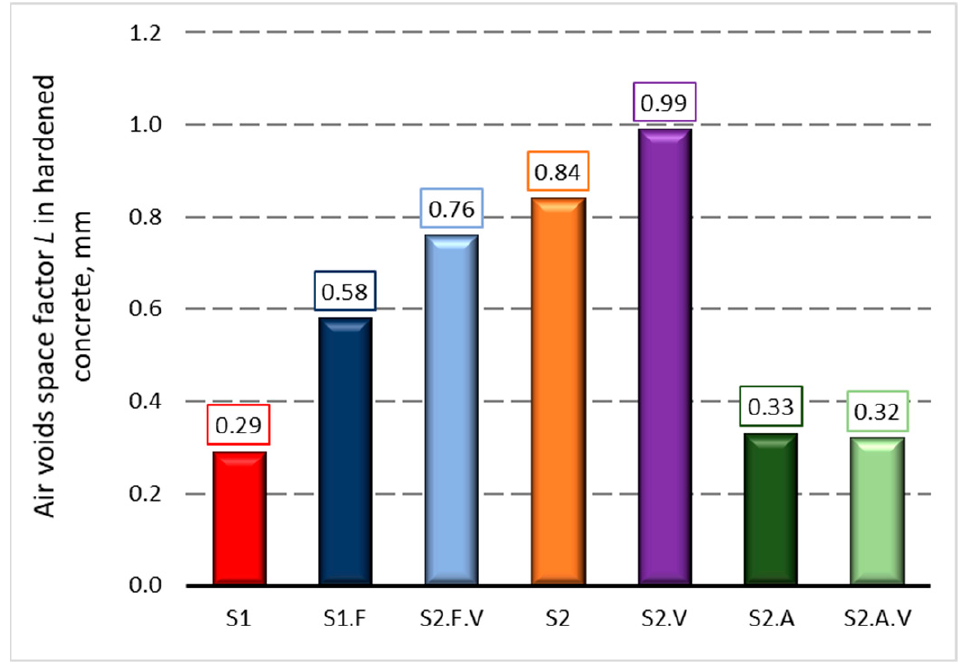
Figure 4. Air voids space factor L in hardened concrete after 28 days of curing.